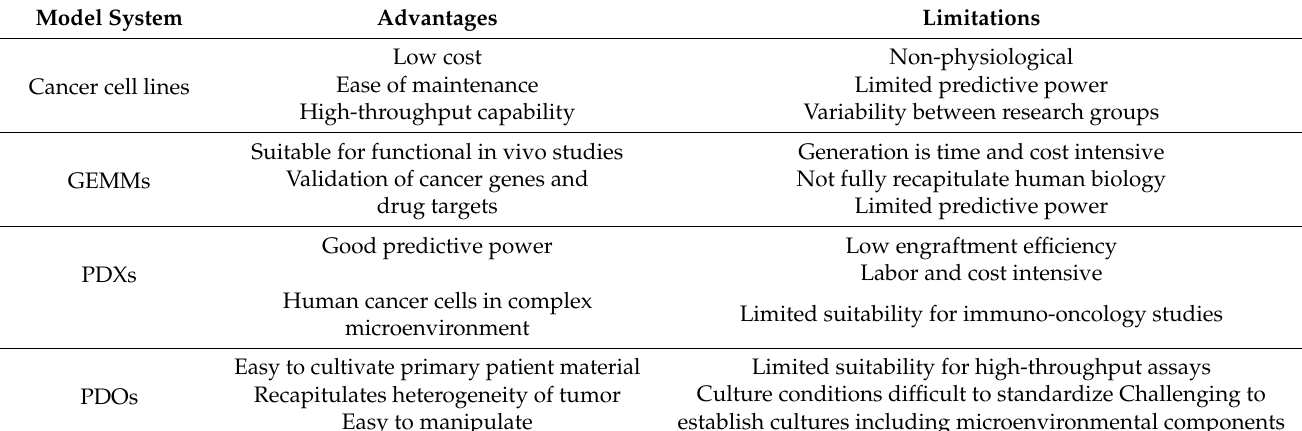
Table 1. Comparison of advantages and limitations of model systems in cancer